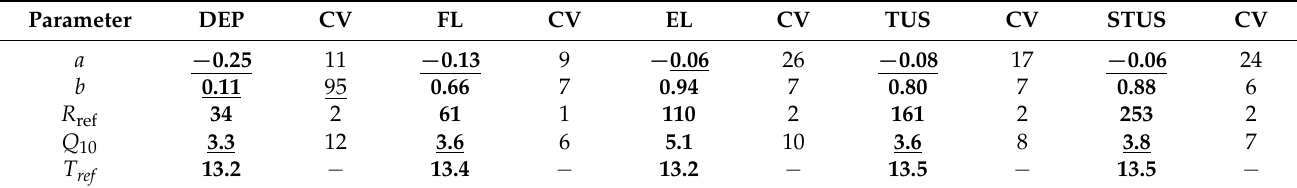
Table 4. Results of parameterization of the soil respiration model without taking into account extra dry periods. Parameters that changed most significantly (twofold or more) are